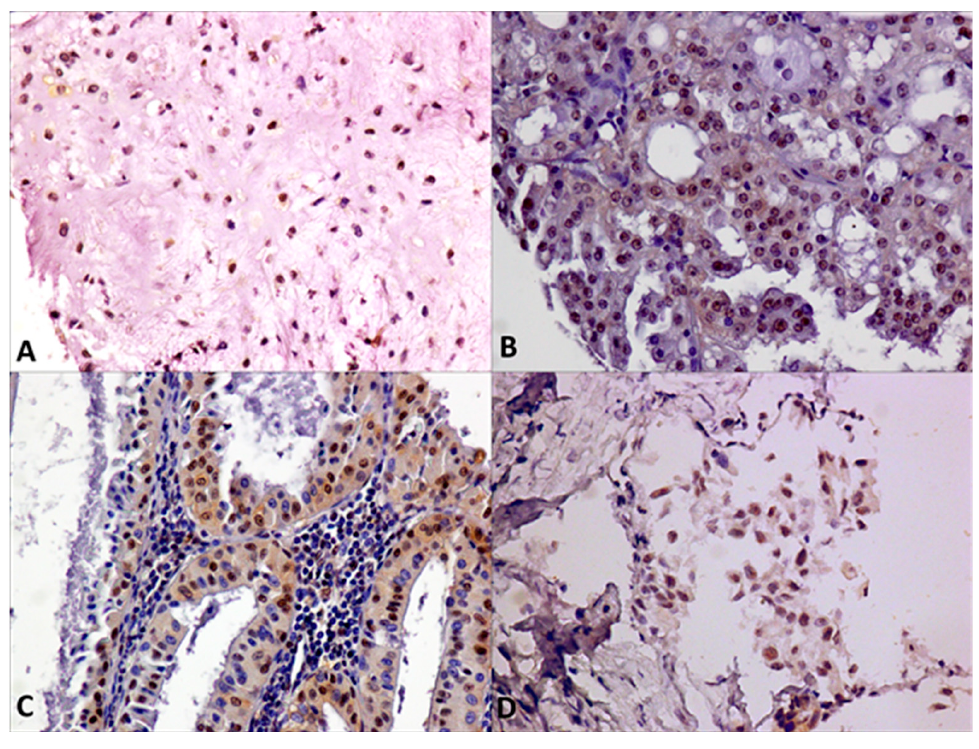
Figure 3. Nuclear ER β IHC staining of SGTs samples: ( A ) PA; ( B ) acinic cell carcinoma (ACC); ( C ) Warthin’s tumor; ( D ) MEC (Magnification 20×).